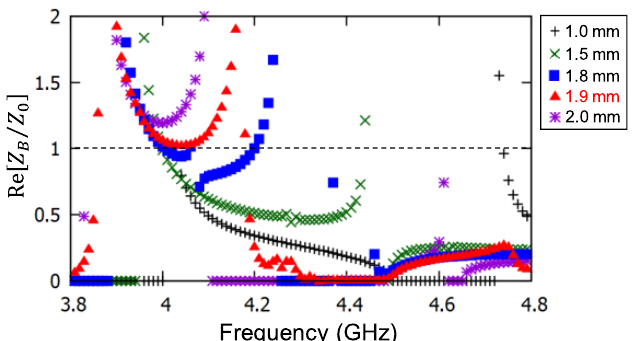
Fig. 9. Simulated real part of the Bloch impedance for the composite structure with printed meander-line